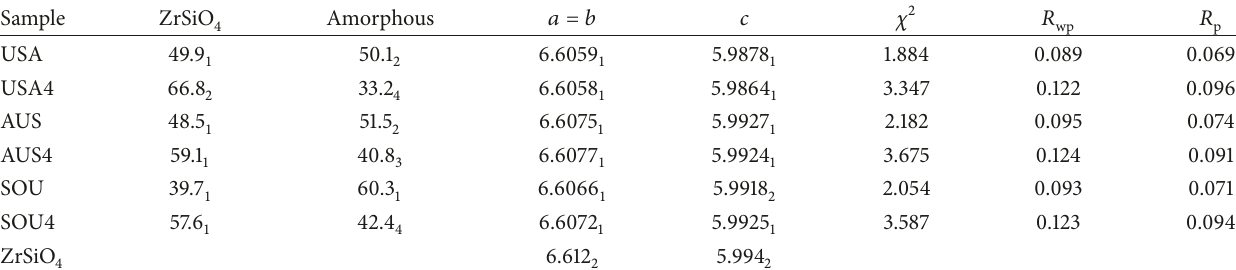
Table 2: Results of Rietveld quantitative analysis (wt%) RIR. Standard parameters for ZrSiO4 are from literature (ICSD 9582).